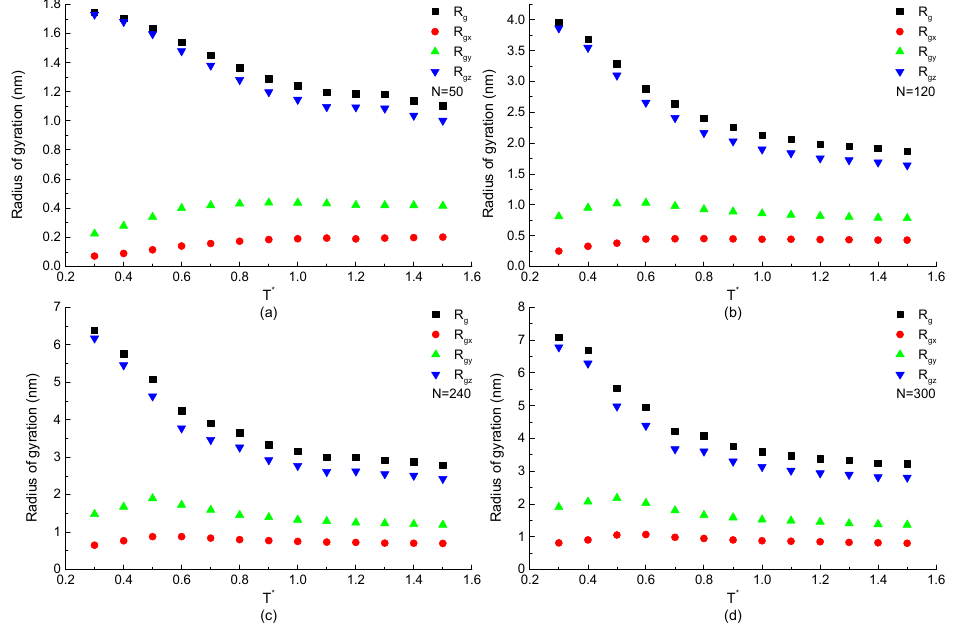
Figure 2. The total and components of radius of gyration versus reduced temperature T * of H3N1P1 proteins with chain length ( a ) N = 50, ( b ) N = 120, ( c ) N = 240, and ( d ) N = 300 residues.